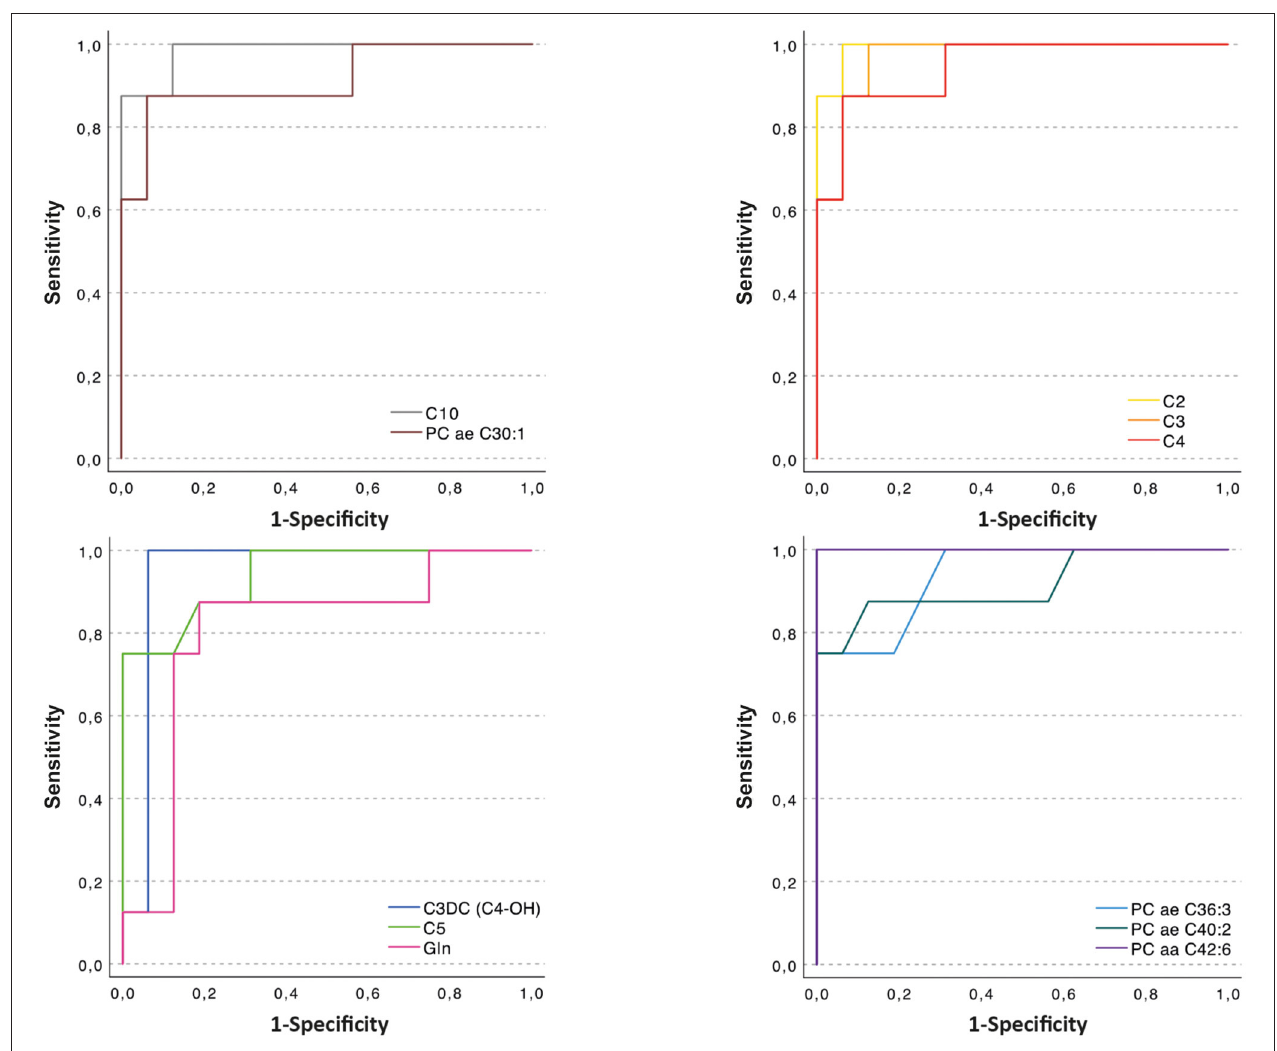
FIGURE 2 | Sensitivity vs. specificity ROC curve of glutamine (Gln) and of the 10 compounds that have a p < 0.0001 score and whose log 2 FC >